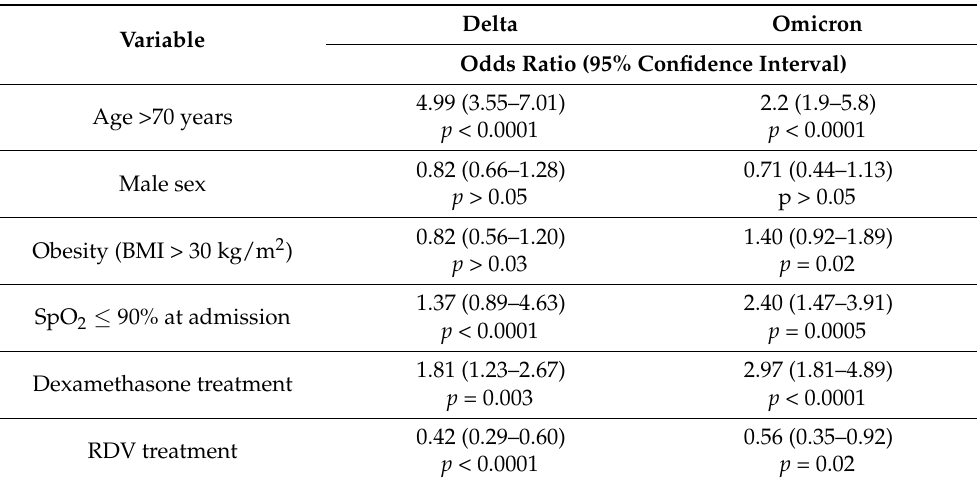
Table 5. Multiple logistic regression on the association between mortality of COVID-19 patients during Delta and Omicron waves and selected variables, including remdesivir treatment